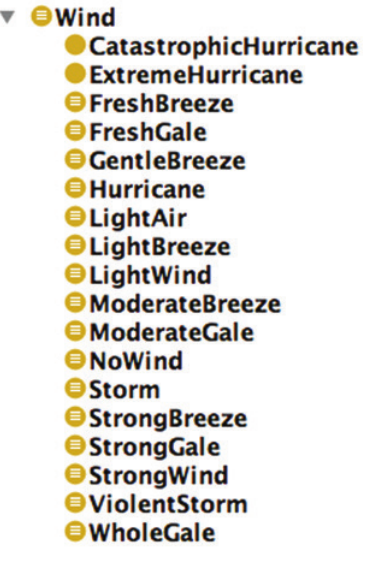
Figure 1: Weather Ontology